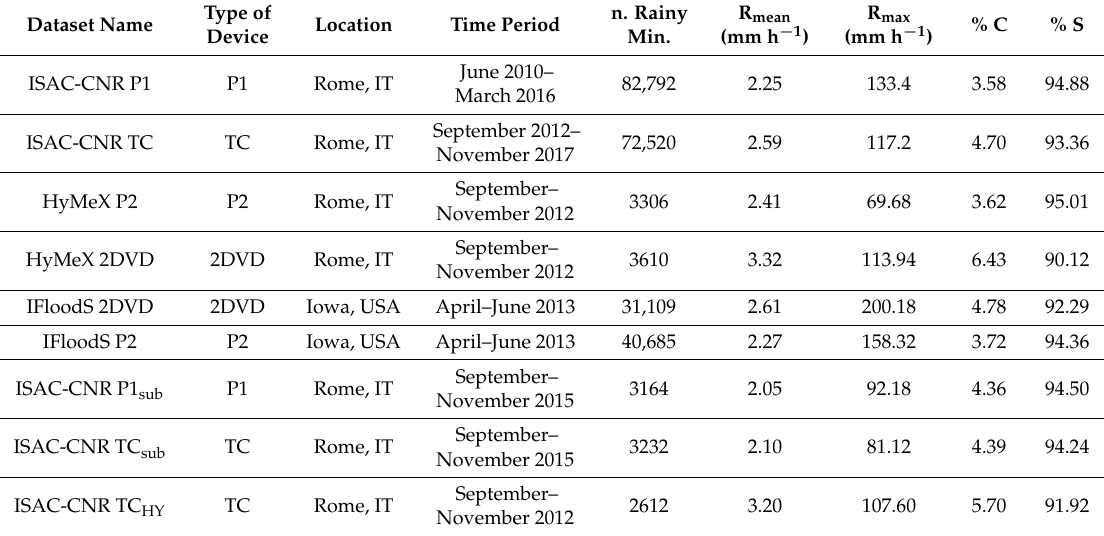
Table 1. For each dataset, provided are the type of device, the location, the time period when measurements were collected, the total number of rainy minutes considered after the application of the filtering, the mean and maximum values of the rainfall rate and the percentage of minutes classified as Convective (C), or Stratiform (S), applying the [40] classification